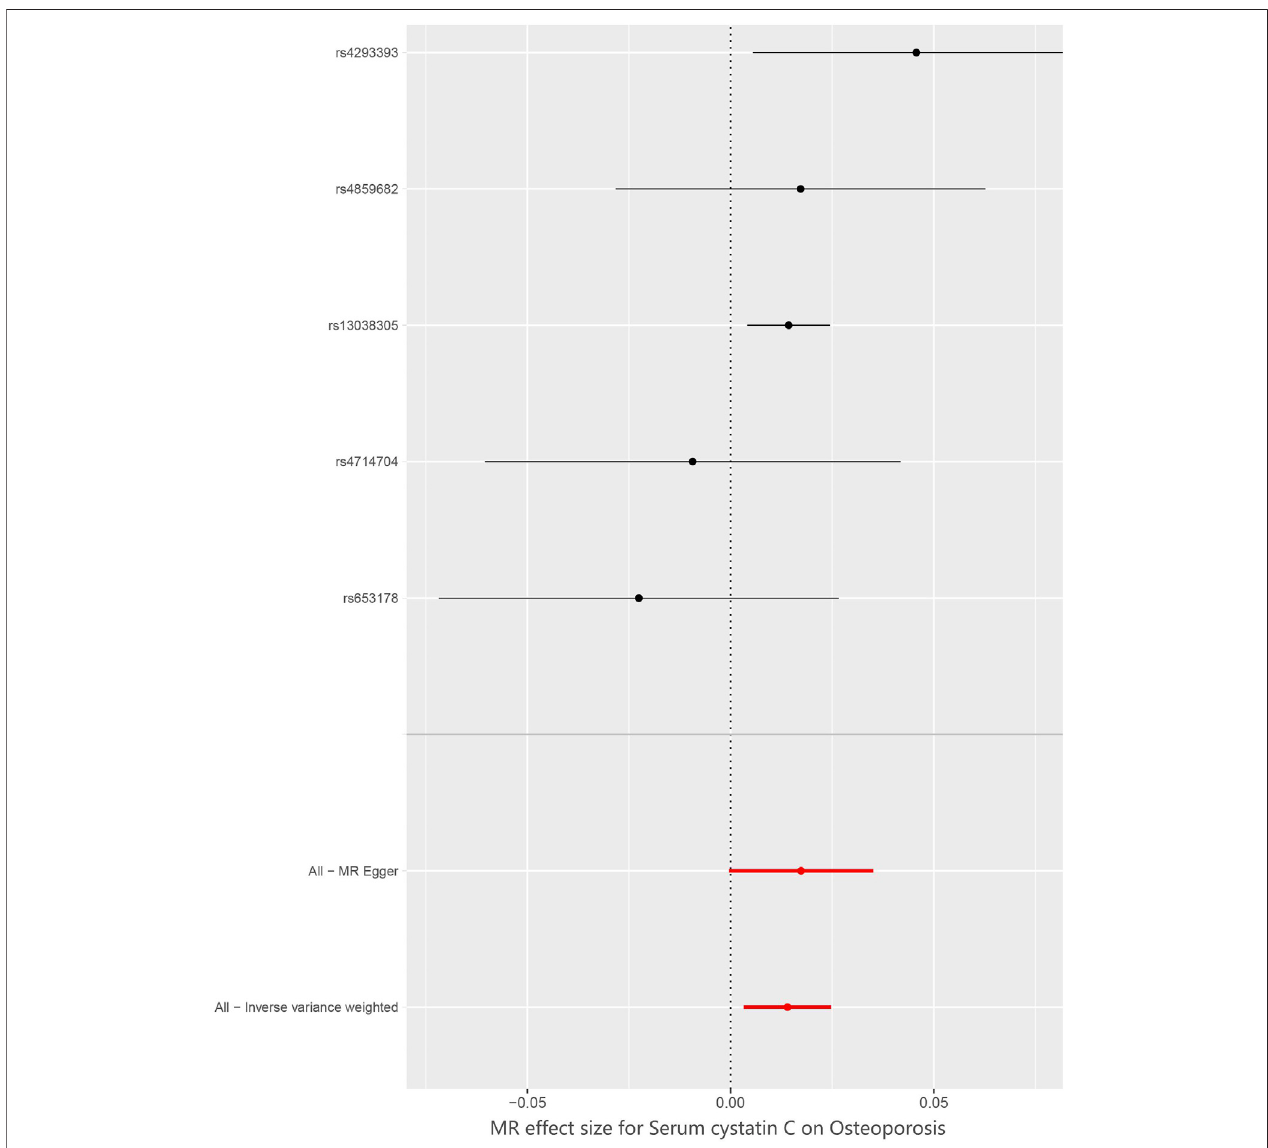
FIGURE 3 | Forest plot to visualize causal effect of each single SNP on osteoporosis risk.